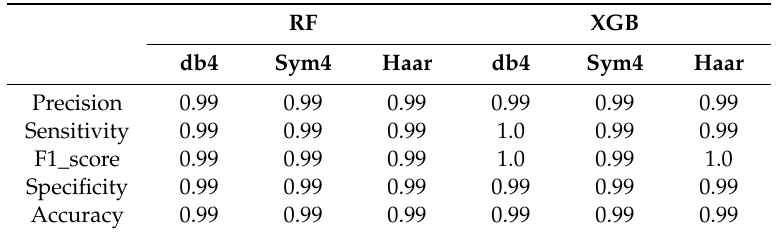
Table 7. The five evaluation parameters of two classifiers for three wavelets executed on the filtered signal.